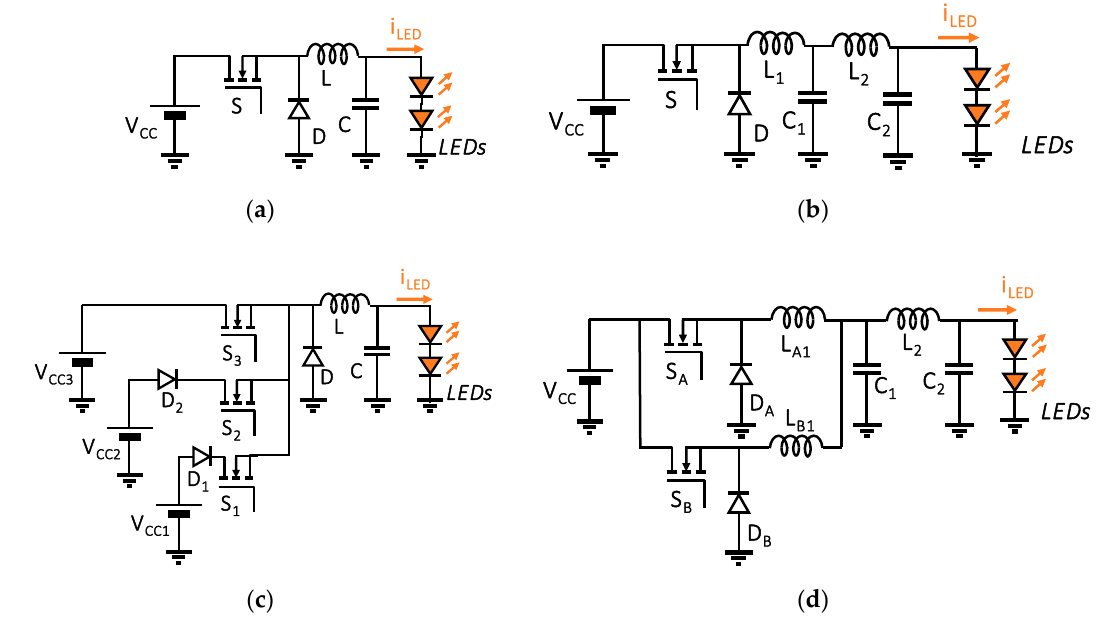
Figure 8. Derivations of the buck DC–DC converter. ( a ) conventional; ( b ) higher order output filter; ( c ) multi-input; ( d ) multiphase.